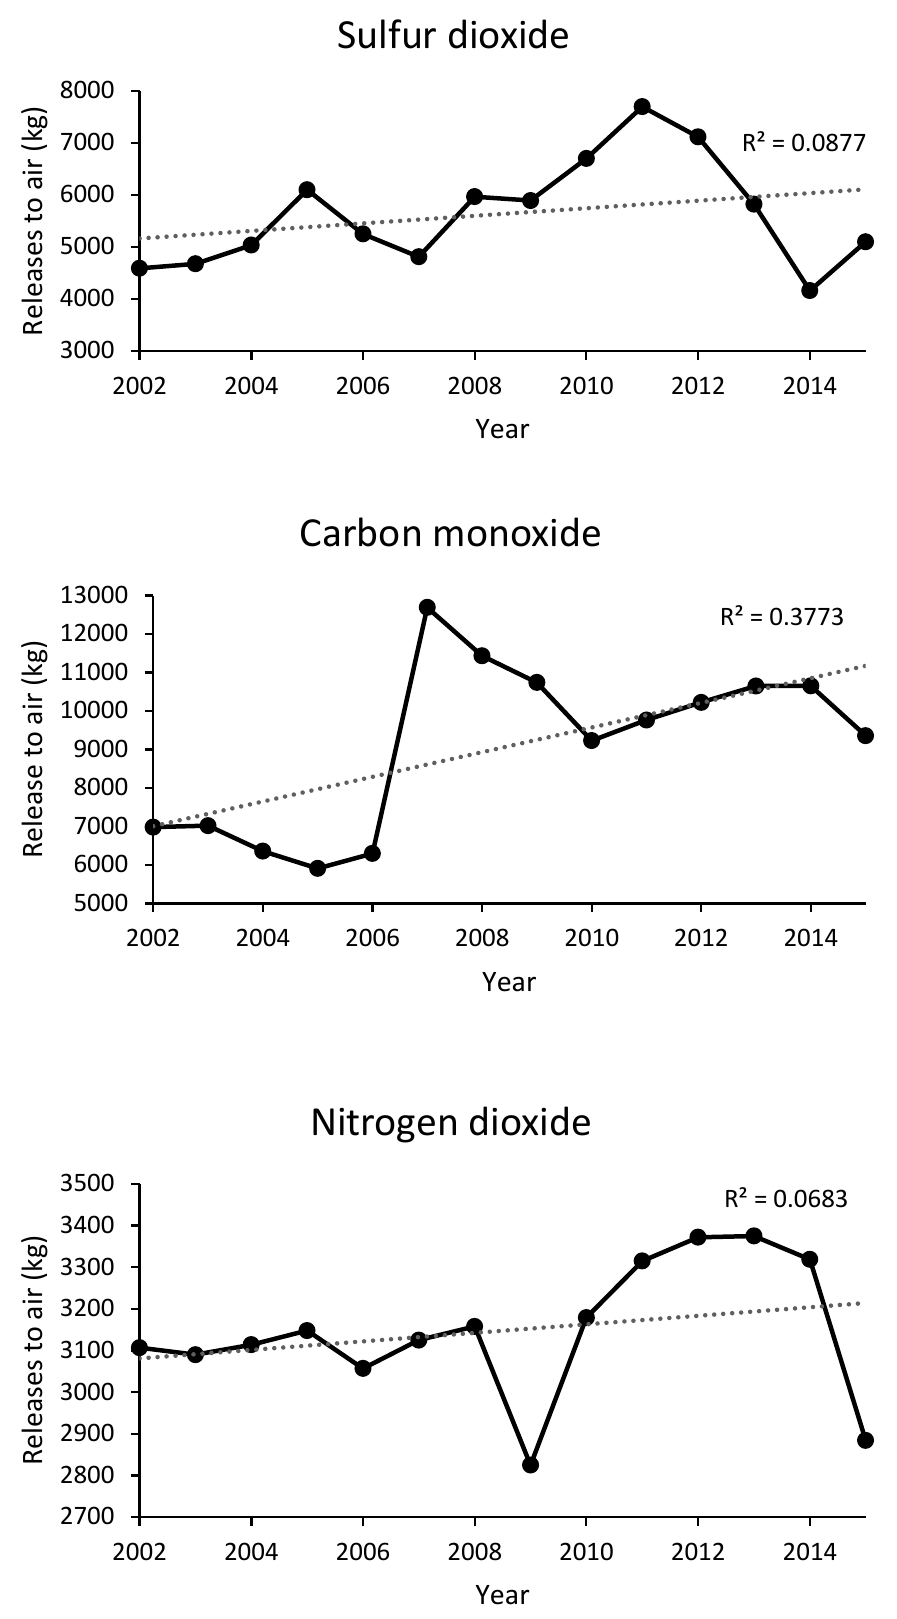
Figure 3. Steel industry NPRI data (kg) from 2002 to 2015.